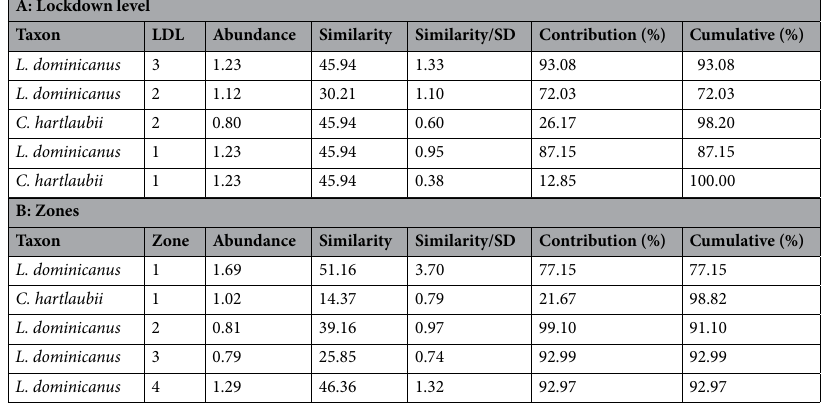
Table 3. Results of SIMPER analysis showing shorebird species contributions (90% cut-off limit) to average dissimilarity among lockdown levels (A) and zones (B) in Muizenberg Beach. 4th-root transformed data from 2020, lockdown levels 3-1, were used in the analysis. Abundance = numerical abundance per species; Similarity = intra-group similarity; Similarity/SD = similarity/standard deviation; Contribution (%) = relative contribution (%) of each species to community structure; Cumulative (%) = joint contribution of species to community